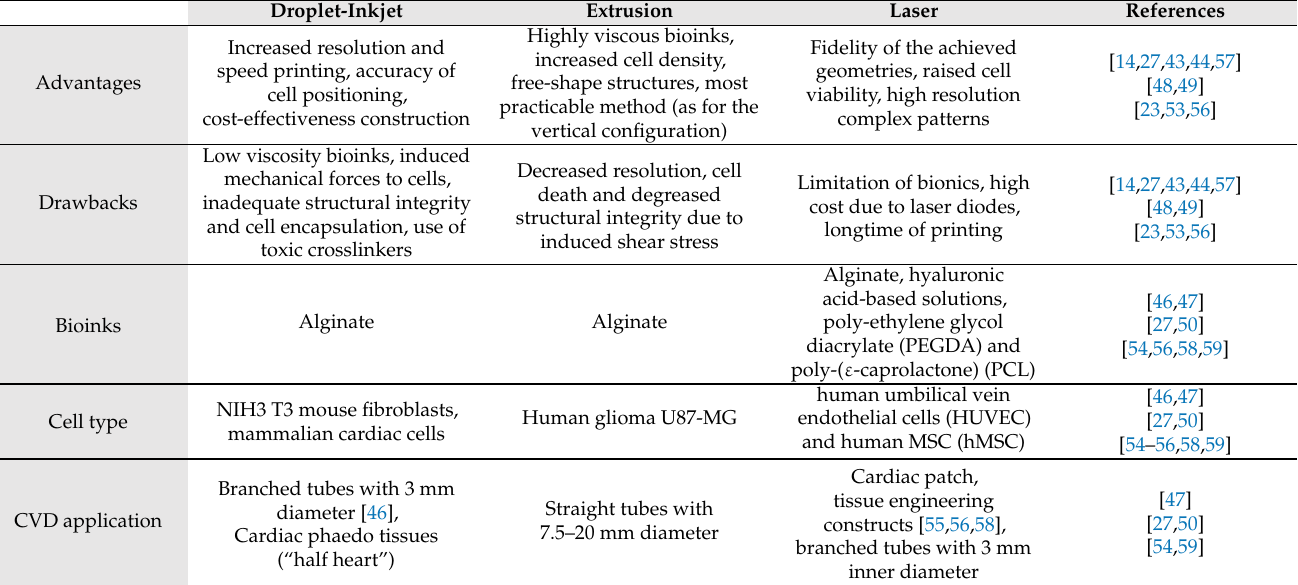
Table 1. Advantages and limitations of 3D bioprinting techniques for CVD treatment.